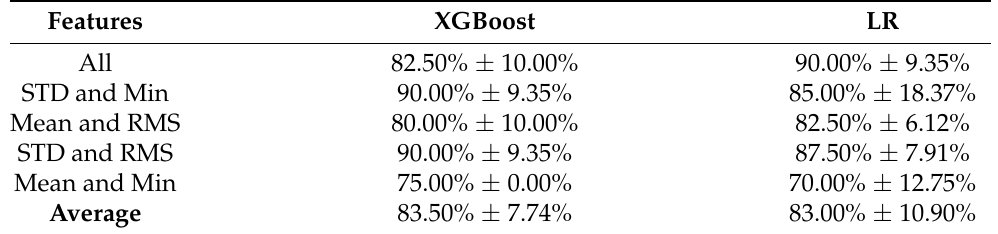
Table 4. XGB and LR accuracy for